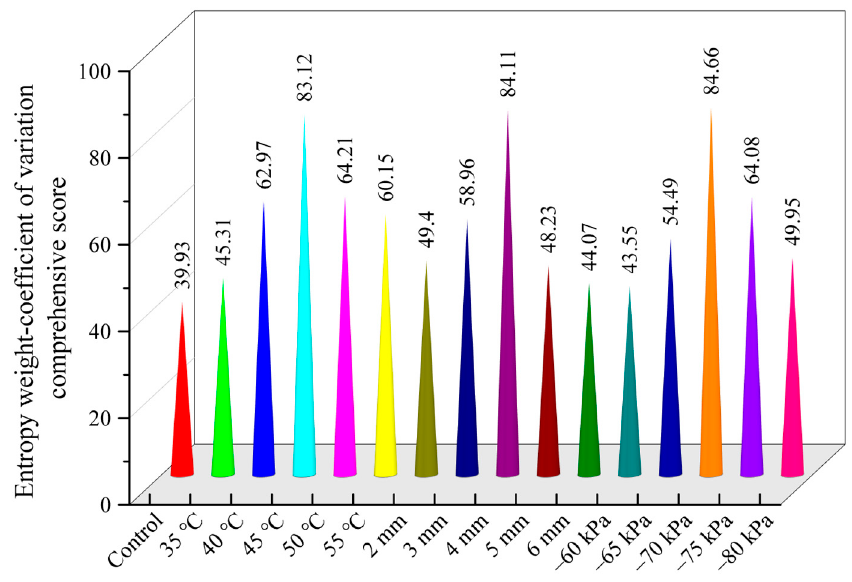
Figure 11. The results of entropy weight-coefficient of variation comprehensive score under different drying conditions.